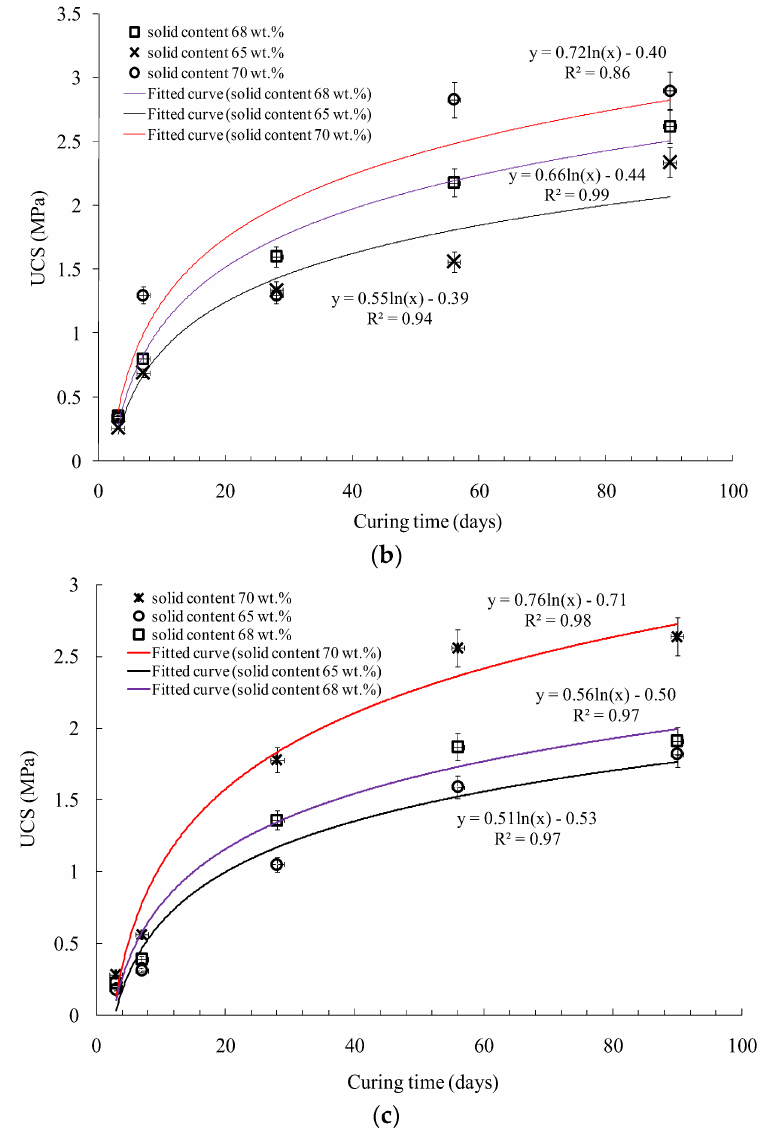
Figure 8. Diagram of backfill strength growth of different cement/tailings ratio: ( a ) 25 wt %; ( b ) 15.6 wt %; ( c ) 12.5 wt